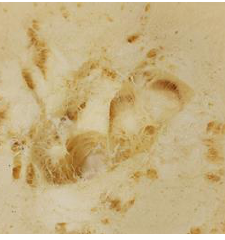
Figure 9. Disturbances in the cellular structure of the foam W22_0.6. Table 5. Characteristics of the cellular structure of PU foams with different isocyanate indices.